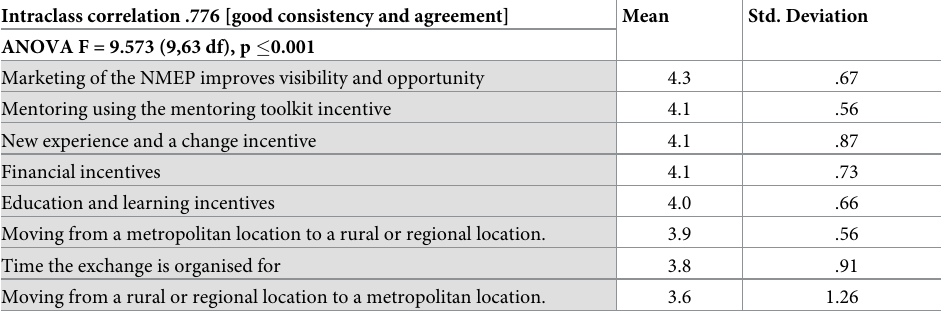
Table 4. Rate how you regard the following components of the NMEP program toward the successful recruitment of nurse and midwives. Intraclass correlation .776 [good consistency and agreement] Mean Std. Deviation ANOVA F = 9.573 (9,63 df), p � 0.001 Marketing of the NMEP improves visibility and